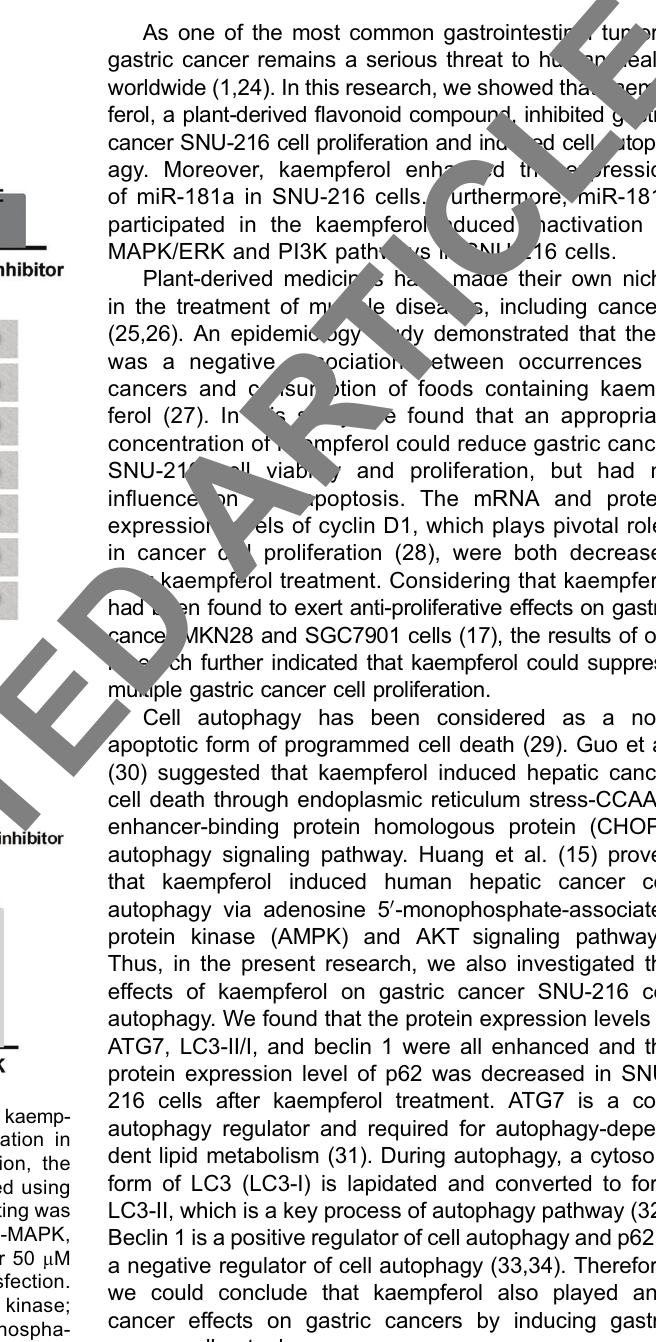
Braz J Med Biol Res | doi: